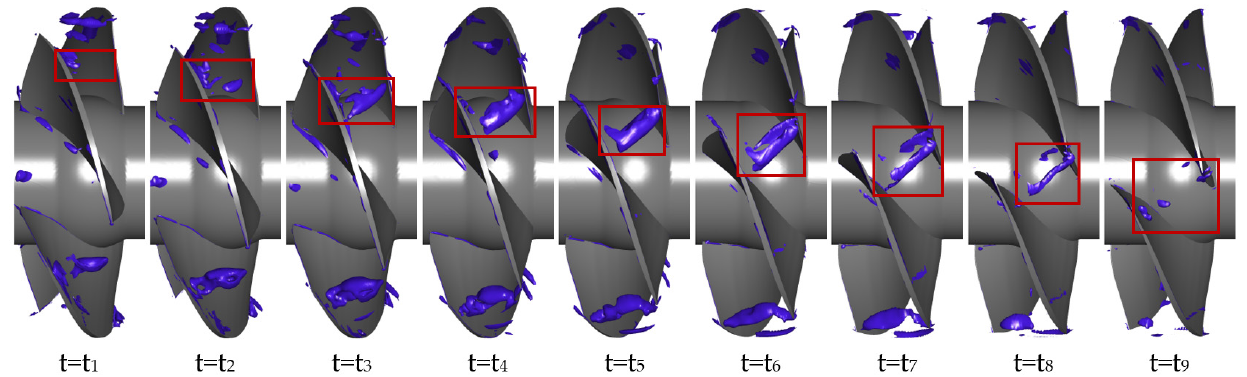
Figure 11. Liutex vortex recognition isosurface.